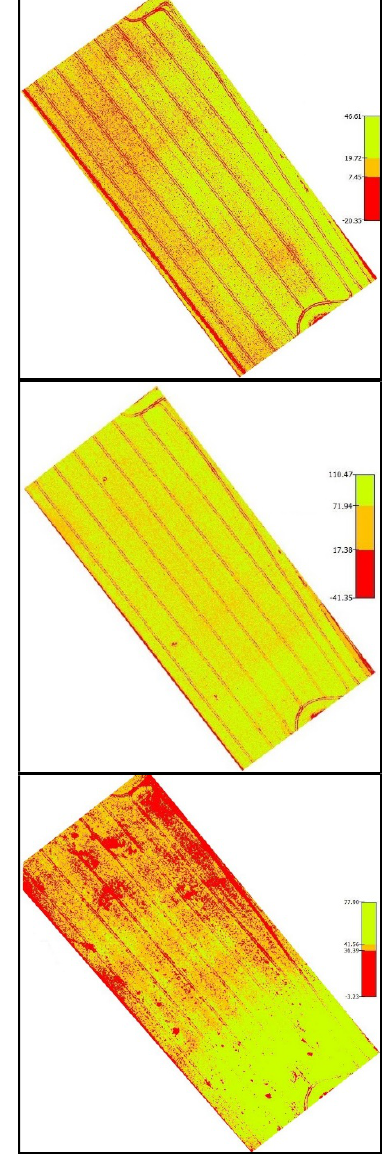
Figure 4 – TGI maps for rape crops (A – germinating, B